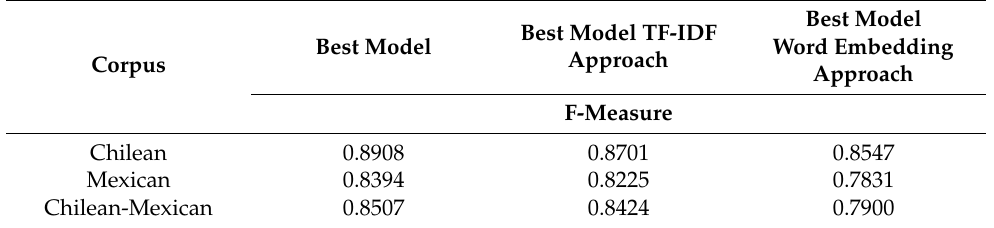
Table 12. F-measure comparison of the best models with the best base